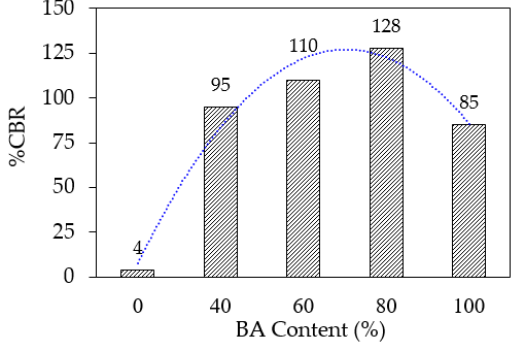
Figure 5. Soaked CBR values of the uncemented specimens.